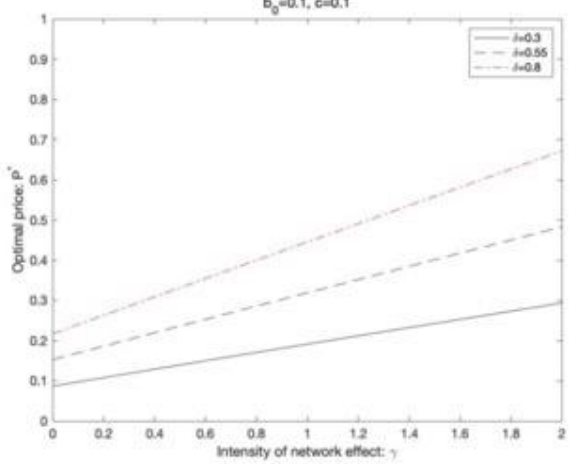
Figure 4. The impact of network effect intensity 𝛾 on pricing strategies.